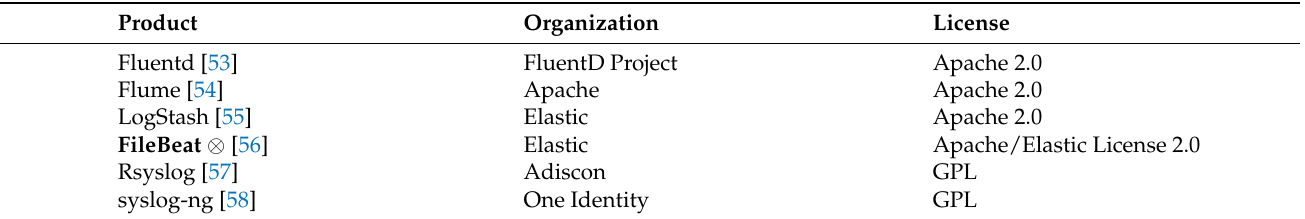
Table 2. Often seen forwarding solutions for log consolidation. Products used in this study are marked bold ⊗ , without claiming